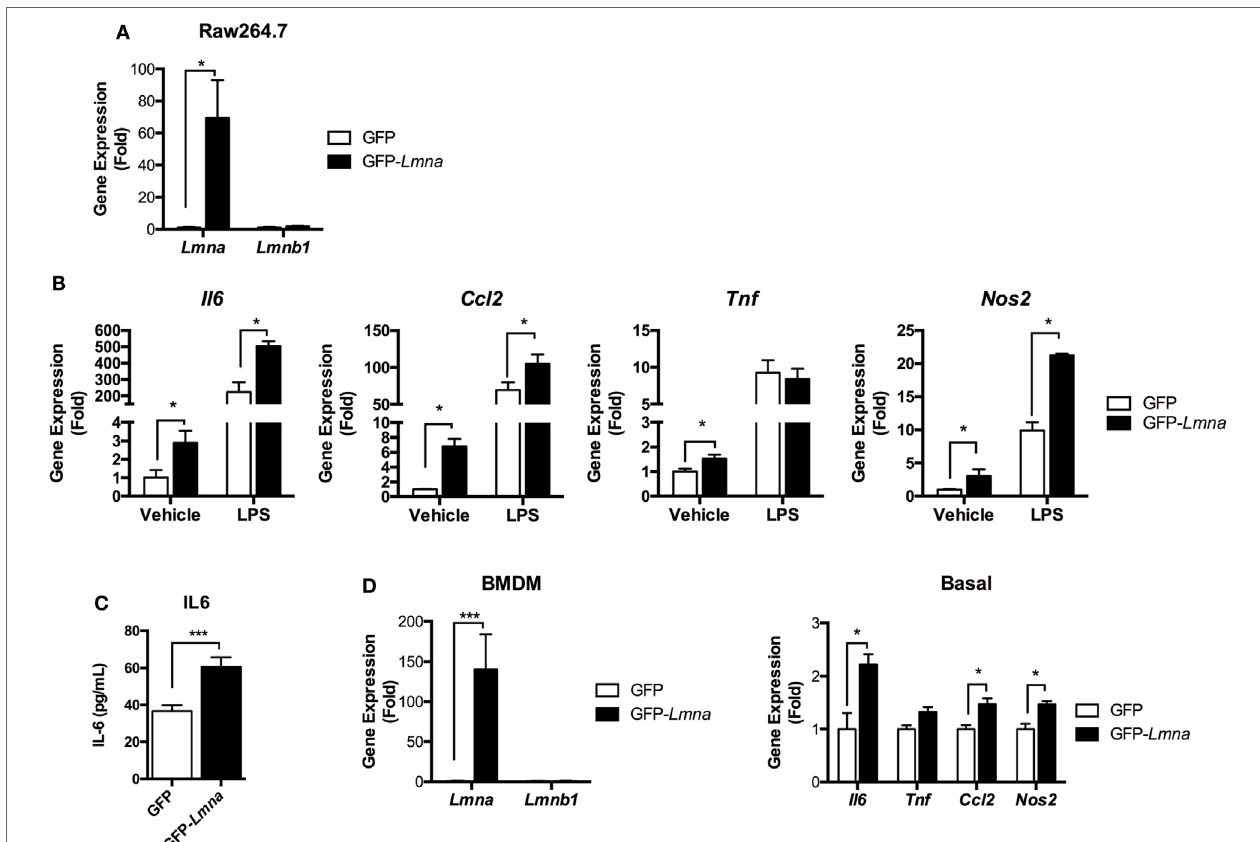
FigUre 3 | Lamin A/C overexpression induces proinflammatory cytokine expression in macrophages. (a–c) Raw 264.7 cells were transfected with GFP or GFP- Lmna . After 24 h, transfected cells were cultured in the absence or presence of 100 ng/ml LPS for 6 h. (a) Quantitative real-time RT-PCR (qRT-PCR) analysis of Lmna and Lmnb1 in GFP or GFP- Lmna -transfected cells. (B) qRT-PCR analysis of Il6, Tnf, Ccl2, and Nos2 in GFP or GFP- Lmna transfected cells. (c) ELISA of IL-6 in supernatant of Raw 264.7 cells transfected with GFP or GFP- Lmna in the absence of LPS. (D) Characterization of bone marrow-derived macrophages (BMDMs) transfected GFP- Lmna. qRT-PCR analysis of Lmna and Lmnb1 (left) and Il6, Tnf, Ccl2, and Nos2 in GFP or GFP- Lmna transfected BMDMs (right). Error bars represent SEM. * p < 0.05, *** p <